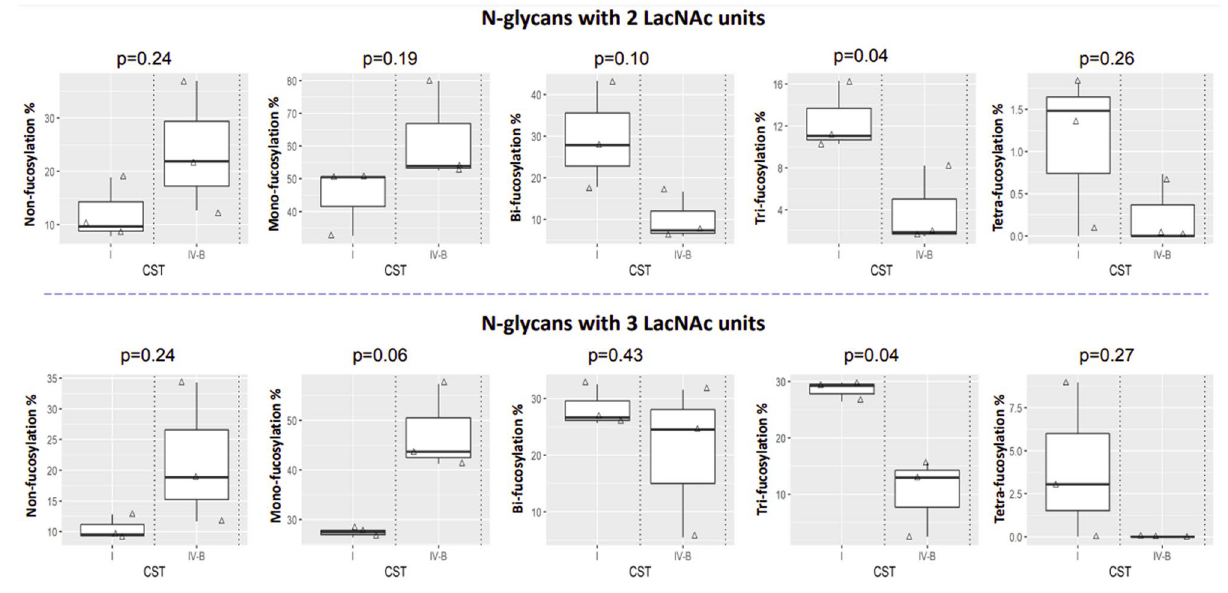
Figure 6. Correlation of CST to fucosylation depended on the number of Fuc per glycan. N-glycans with 2 LacNAc units (top panel) and 3 LacNAc units (bottom panel) were selected for analysis. The proportion of summed intensity of glycans with non-fucosylation, mono-fucosylation, bi-fucosylation, tri-fucosylation and tetra-fucosylation to total glycan intensity was calculated.